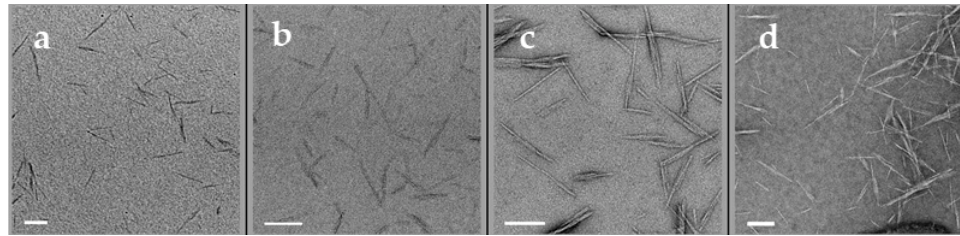
Figure 2. Variation in stain-depth of CNCs shown in BF-TEM images. ( a ) unstained; ( b ) very shallow; ( c ) shallow and ( d ) deep stained CNCs, respectively. Scale bars: 100 nm.